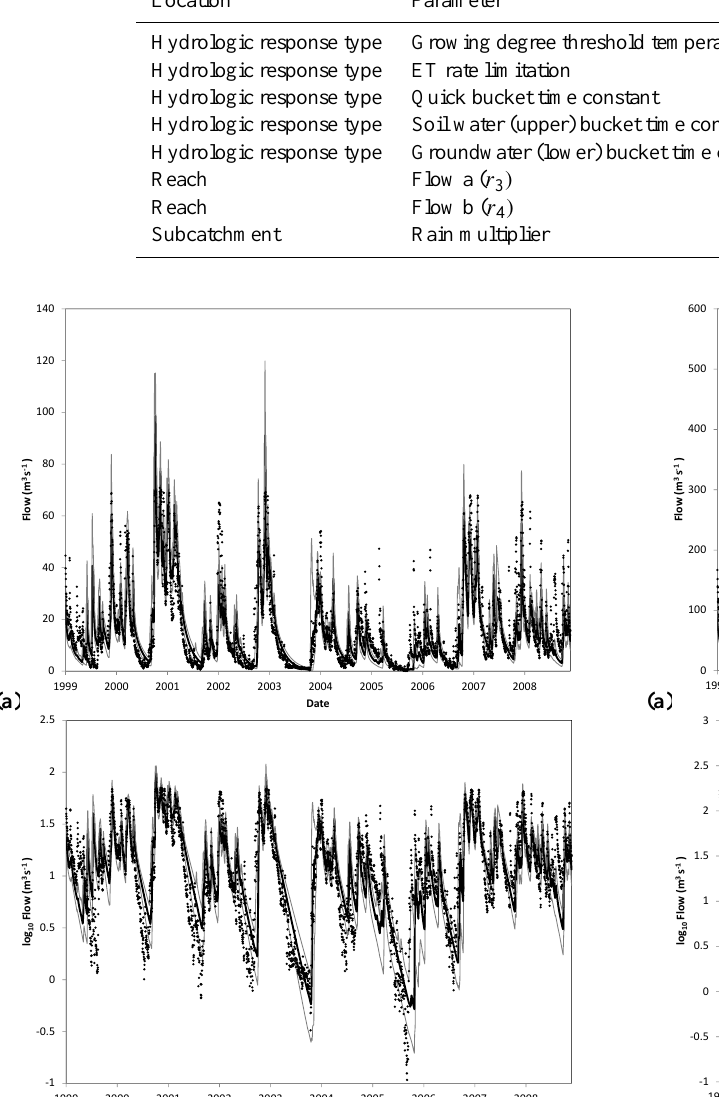
Table 5. Parameter ranges used during MCMC analysis. Note that the range of values used for individual subcatchments and reach were smaller than the overall range shown in the table.